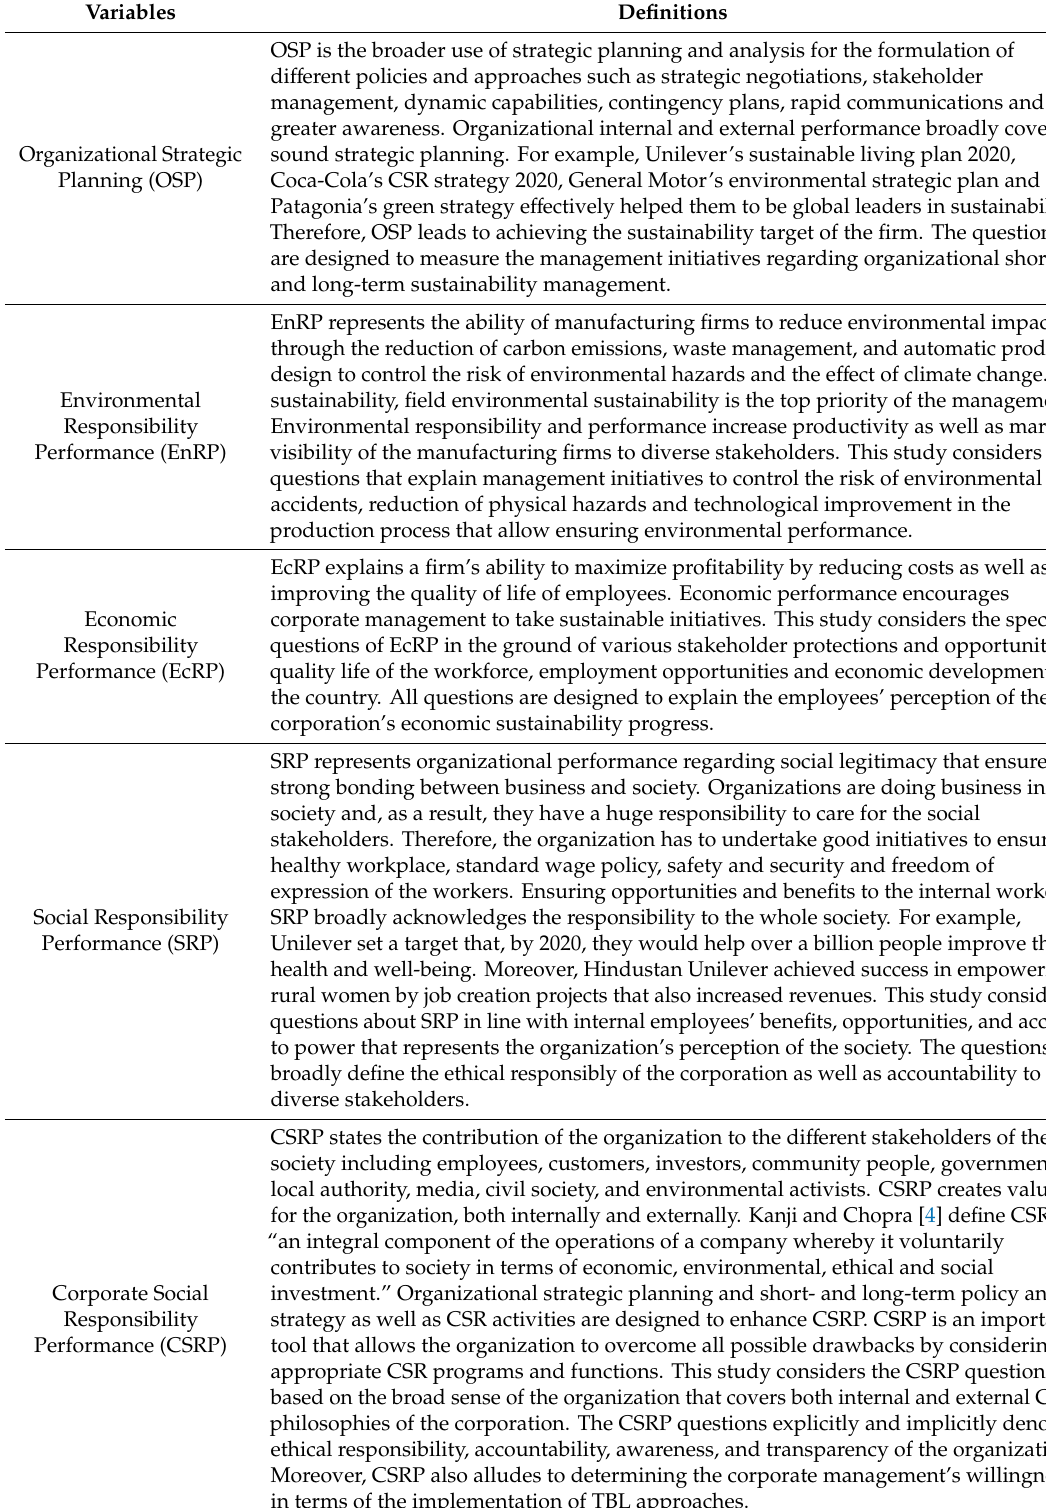
Table 2. Variable